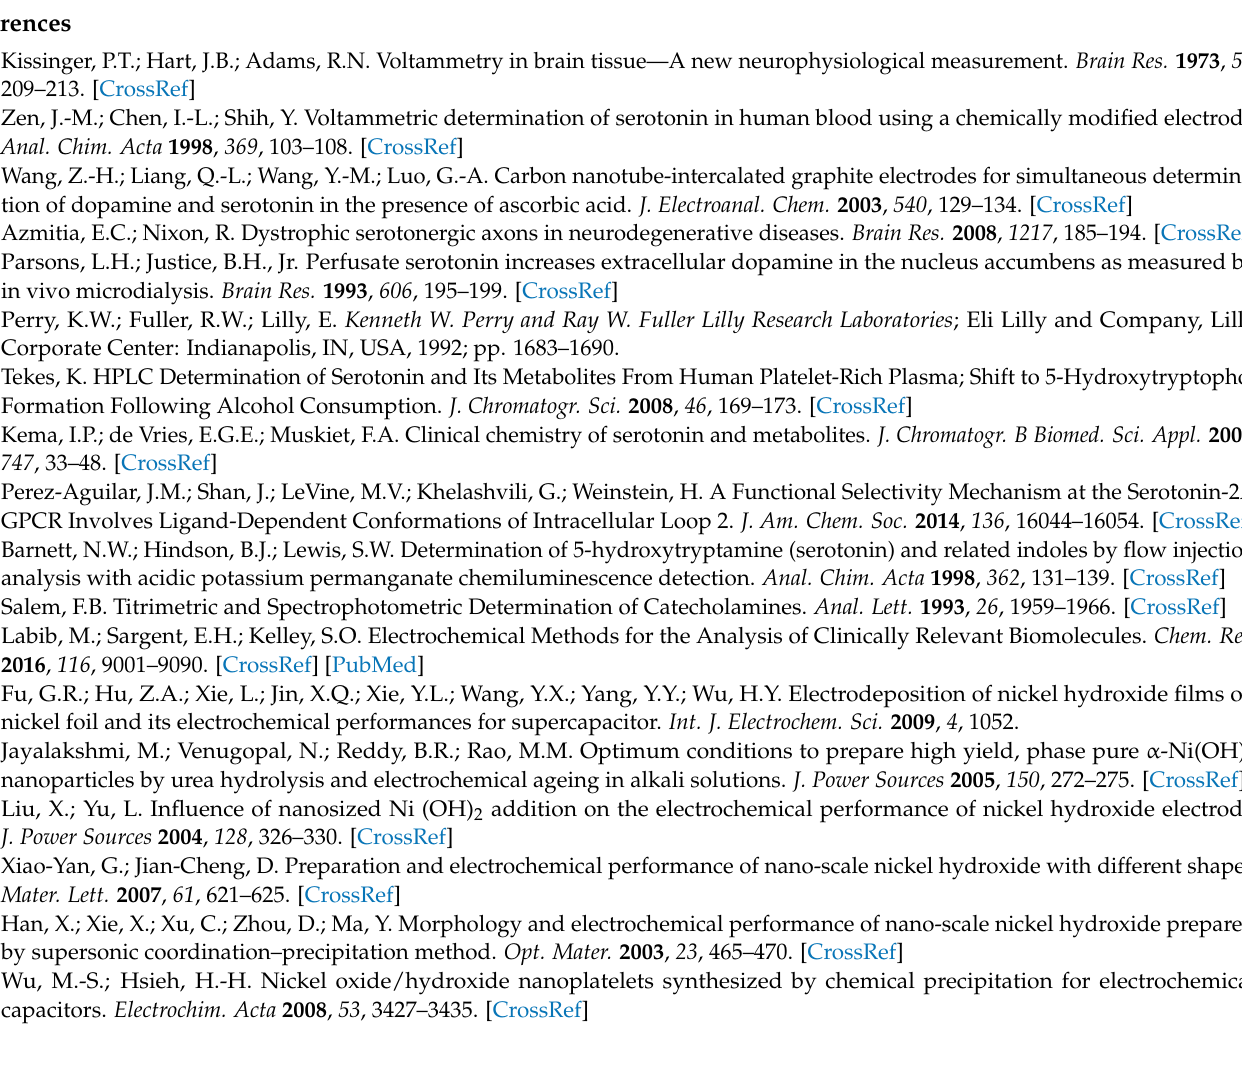
Table S2: Comparison of working concentration range and detection limit of 5-HT by NH-HNP- Chit/SPCE with recently reported